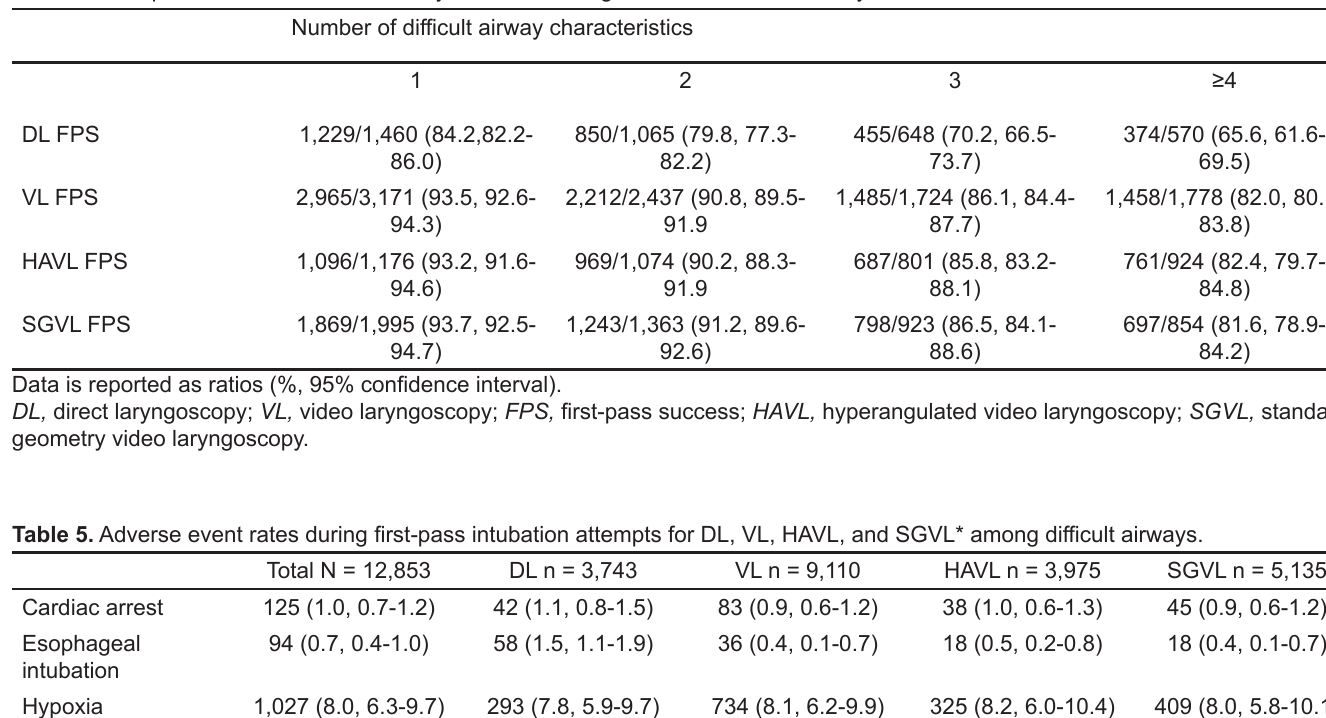
Table 4. First-pass success rates for airways with increasing number of difficult airway characteristics.